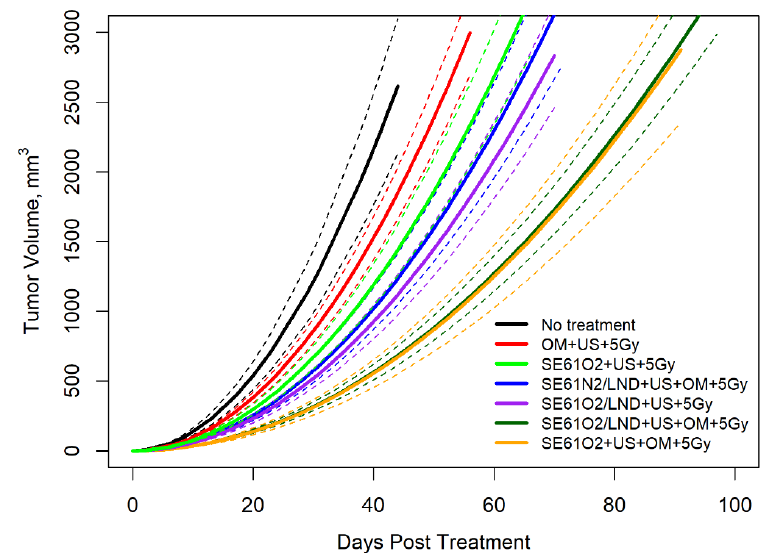
Figure 5. Tumor volumes plotted against time with fitted exponential growth curves showing tumoral response to therapy, with 95% confidence bands shown as dashed lines. Tumor volumes are plotted to the day of treatment to show the influence of ultrasound (US), SE61 microbubbles, radiation therapy (5 Gy), gas (oxygen or nitrogen), and tumor mitochondrial respiration inhibitors (metformin (OM) and lonidamine (LND)).